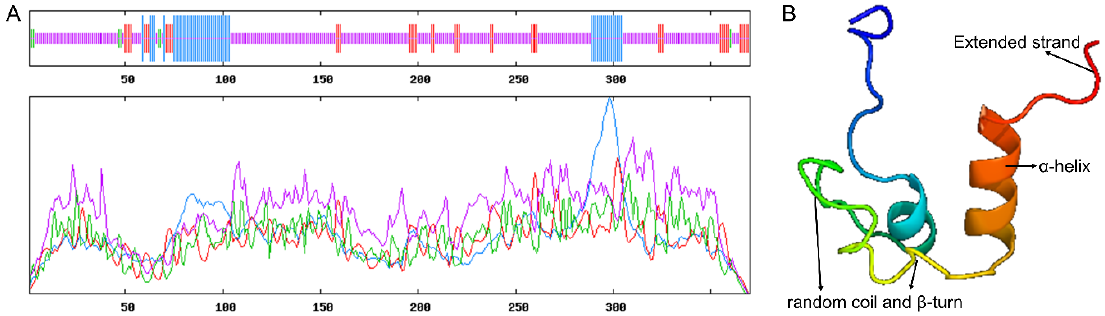
Figure 3. The secondary and tertiary structures of Tibetan sheep DMRTC2 protein. ( A ) Secondary molecular structure. Different lines with different colors denote different secondary structures: blue, alpha helix; red, extended strand; green, beta turn; purple, random coil. ( B ) Tertiary molecular structure.